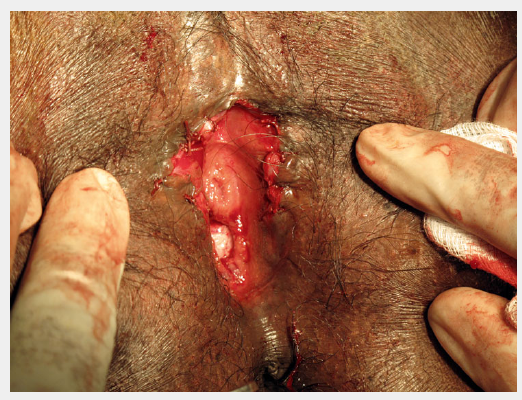
Partial defibulation in FGM/C type IIIb. Photo courtesy of Reference Centre for Preventing and Curing FGM. Department of Gynaecology, Perinatology and Physiology of Reproduction of Florence,